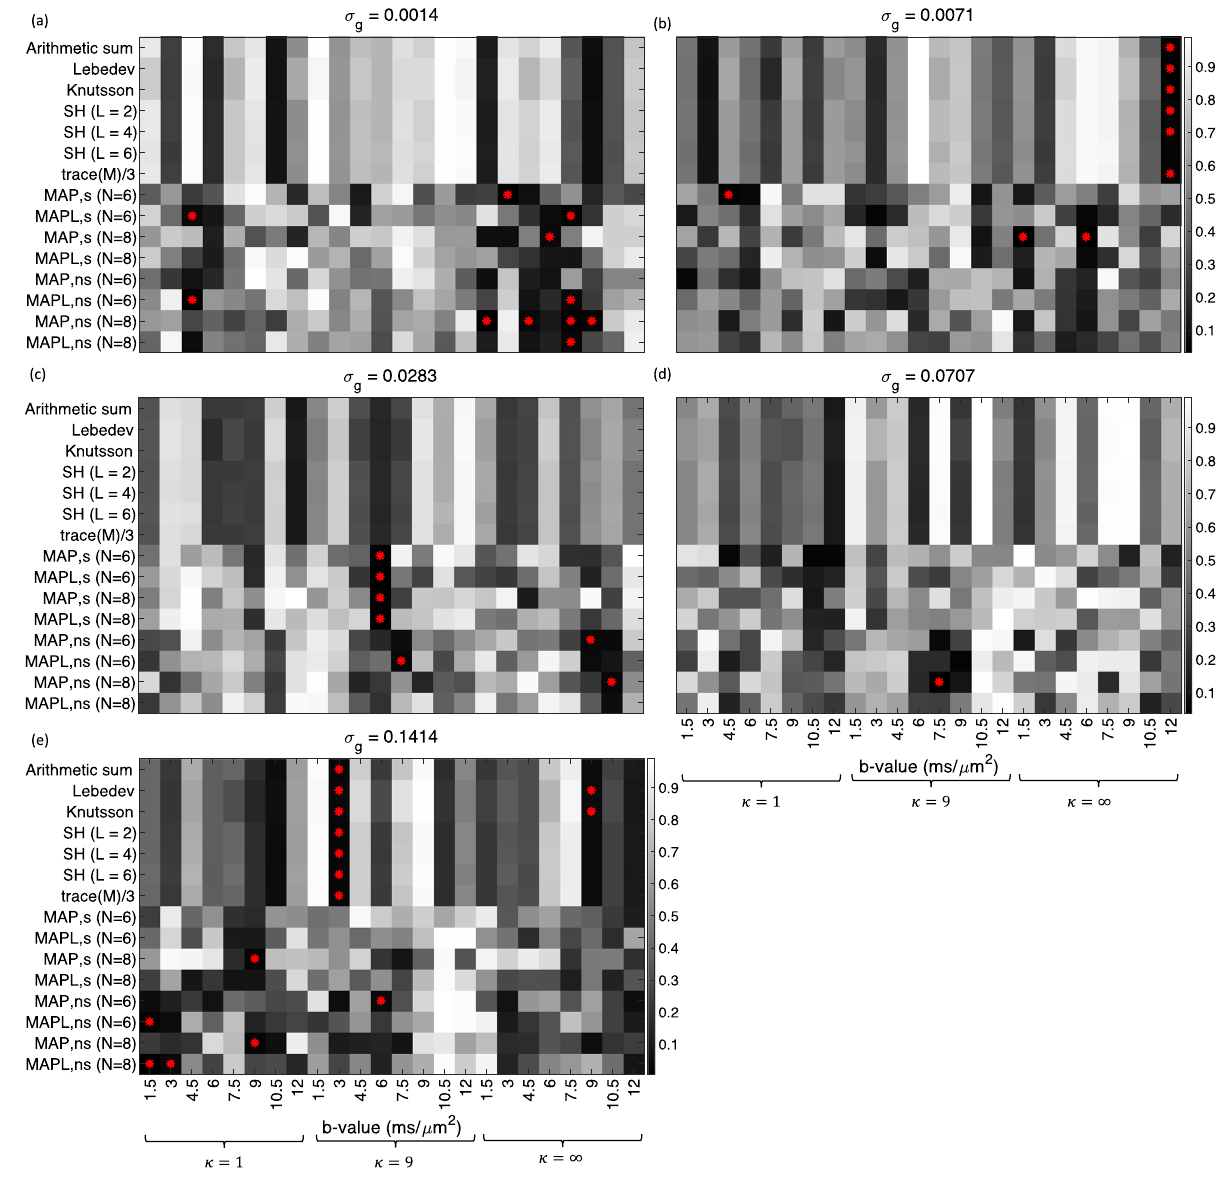
Figure 6. The p -values from the Anderson–Darling test 24 on the orientationally averaged signal obtained from different approaches on 344 (43 8) samples for each b-value and each dispersion value, κ . Panel ( a ) to ( e ) show × 0.0014 in ( a ) to σ 0.1414 in panel ( e ). The red asterisks the p -values for different noise levels from σ g g = = illustrate the schemes that the orientationally averaged signal is not